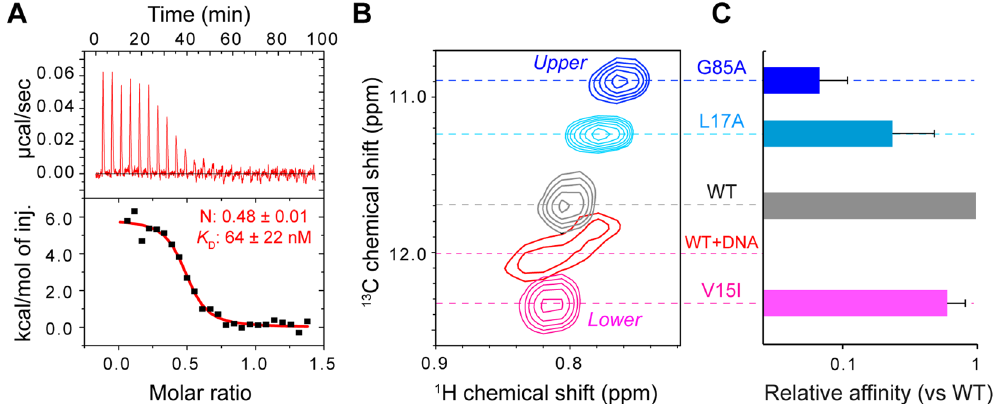
Figure 2. Interaction between LmrR and the PadR-consensus sequence of the lmrCD operator. ( A ) ITC measurements of the interaction between LmrR and the lmrCD operator. The lmrCD operator was titrated to LmrR. ( B ) The Ile 62 1 H δ 1 - 13 C δ 1 signal of wild-type LmrR and the conformationally biased LmrR mutants. The wild-type LmrR signal in complex with the lmrCD operator is also shown. ( C ) DNA affinities of the conformationally biased LmrR mutants relative to the wild-type LmrR. Data are representative of two independent